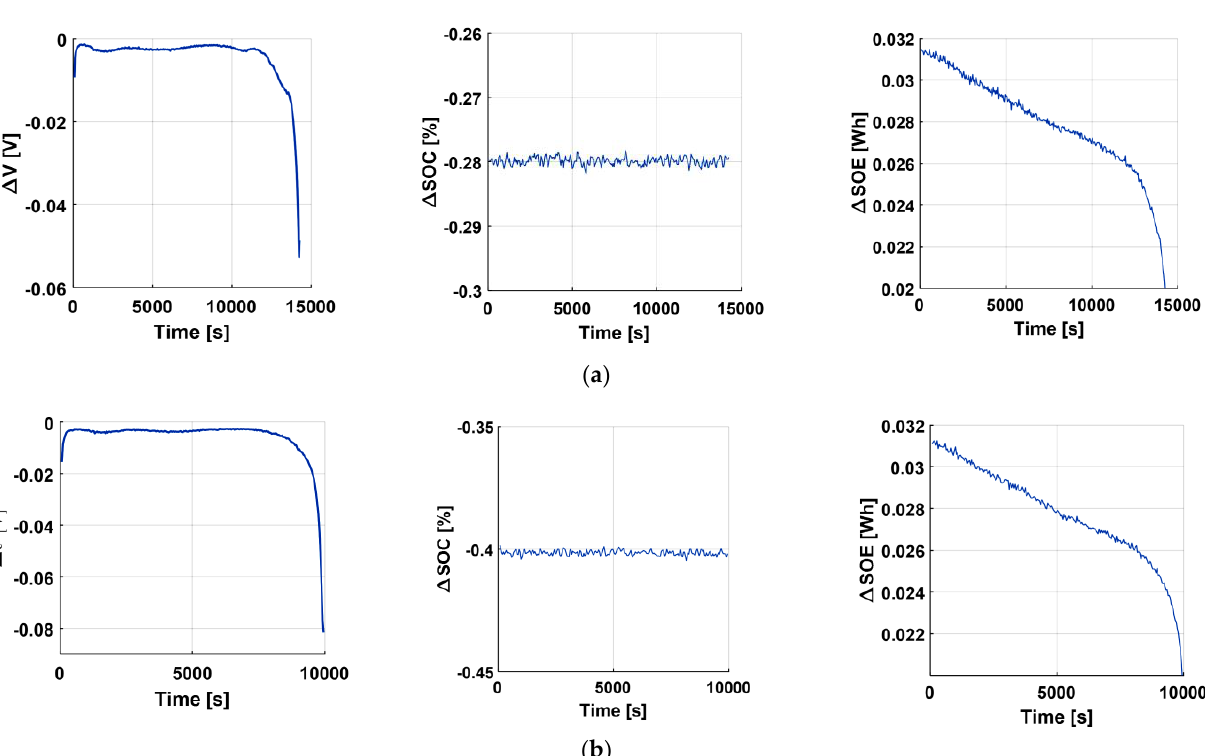
Figure 8. Feature extraction across buffer of time length of 40 s. ( a ) Relative values of voltage, SOC, and SOE in the first cycle. ( b ) Relative values of voltage, SOC, and SOE in the last